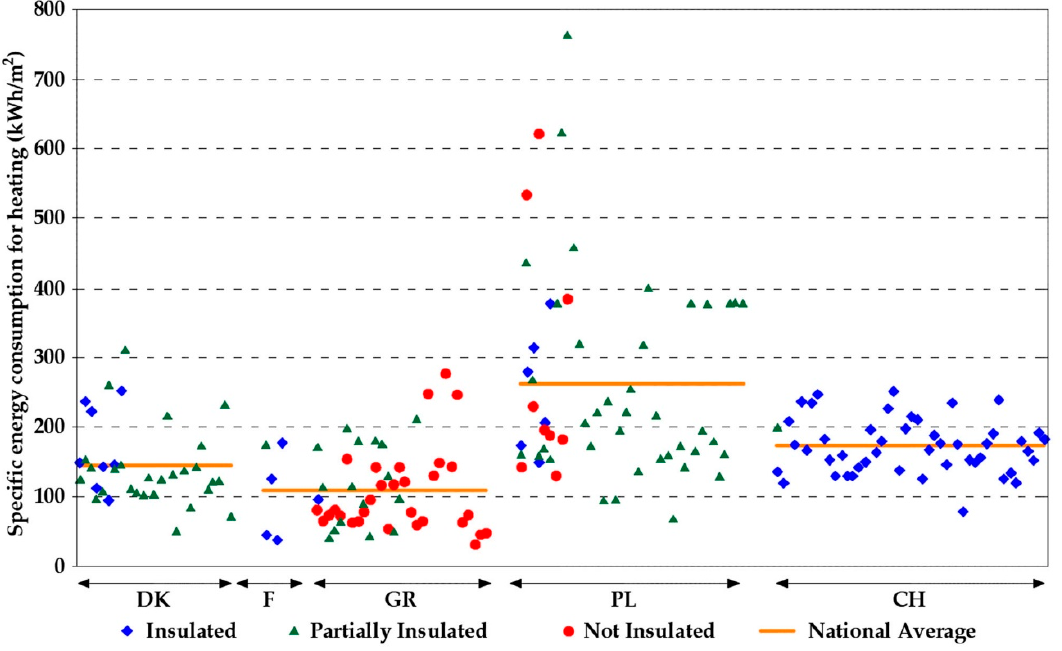
Figure 1. Specific energy consumption for indoor space heating in five different countries and for different buildings regarding their insulation adequacy [5].